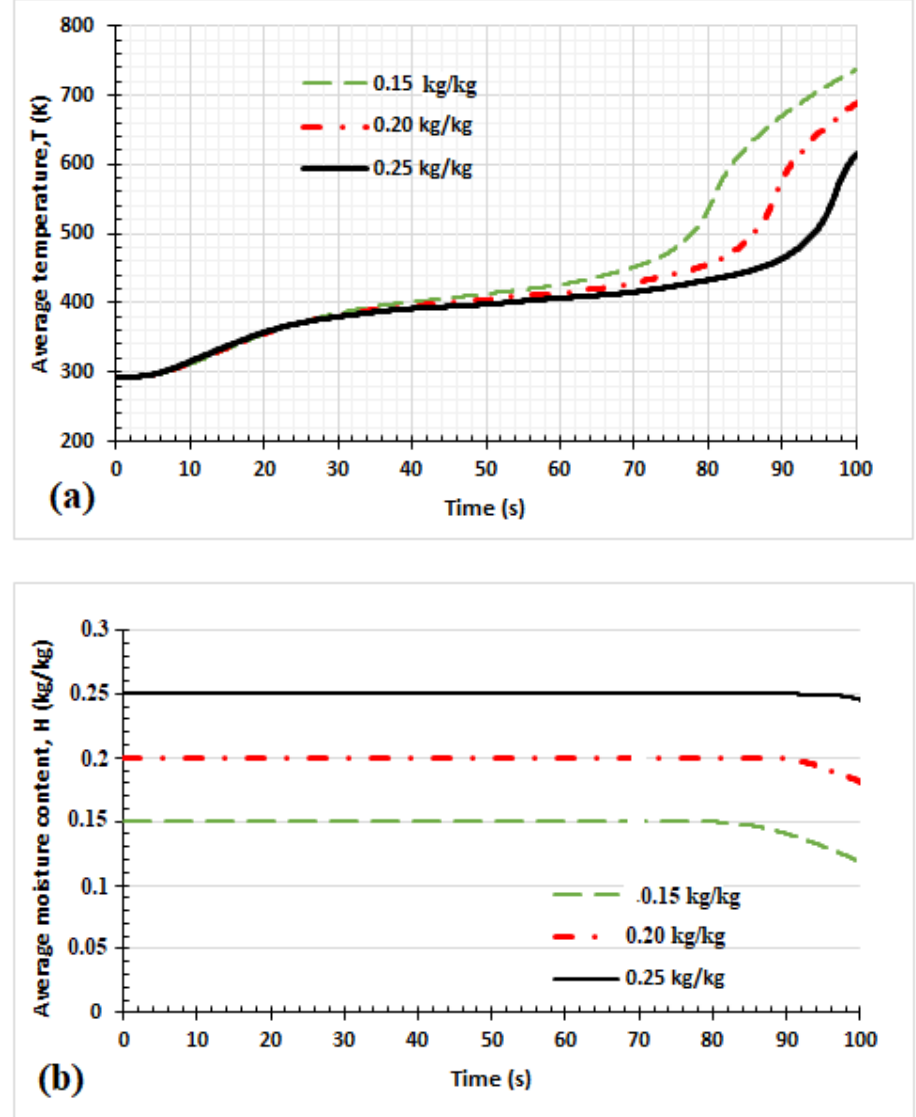
Figure 5. Influence of the initial moisture content on the moisture content and temperature in the middle of the sample. Evolution of the temperature of the center of the sample ( a ); evolution of the moisture content of the center of the sample ( b ); thickness = 1 cm, Tf = 973.15 K, ρ binitial = 700(1 + H ) kg/m 3 q 1 = q 2 = 0 W/m 2 i